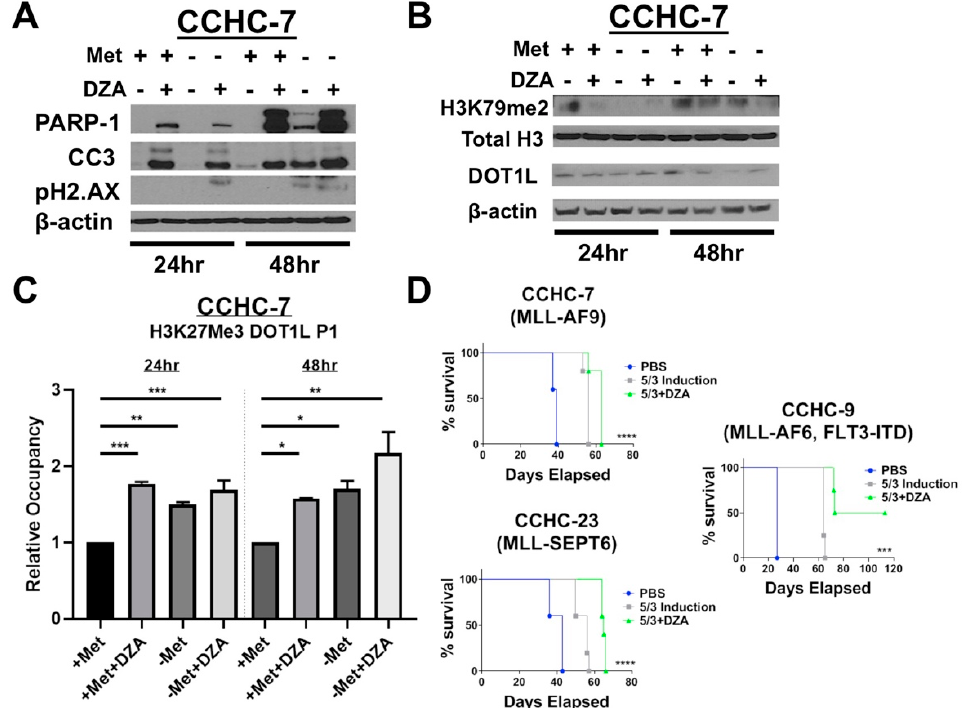
Figure 5. Patient-derived MLL-R leukemic blasts are sensitive to perturbation of Met/SAM metabolism and show changes in global and DOT1L promoter–specific histone methylation dynamics consistent with tested MLL-R cell lines. Combining DZA with 5 + 3 induction therapy significantly prolonged the life of mice harboring several different MLL-R patient derived xenografts. ( A ) Patient-derived CCHC-7 cells behave similarly to the RS411 cell line and only undergo apoptosis following DZA-mediated SAHH inhibition with or without methionine deprivation, as determined by PARP-1 and caspase-3 cleavage. Methionine deprivation for 48 h was also su ffi cient to induce apoptosis and PARP-1 and caspase-3 cleavage. ( B ) CCHC-7 cells show a profound early loss in global H3K79me2 levels